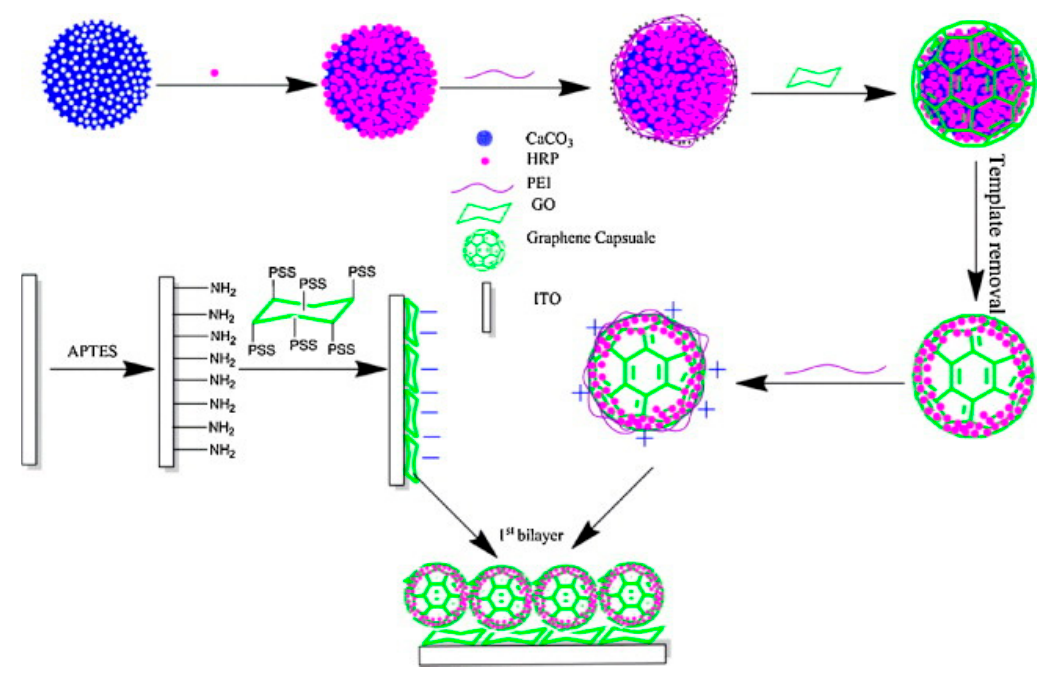
Figure 5. Mechanism of the synthesis of the graphene enzyme composite for the electrochemical sensing of H 2 O 2 . Reproduced with permission from [216]. Copyright 2015, Science Direct. Table 2. Graphene-based enzymatic biosensors for H 2 O 2 detection in Cancerous cells.